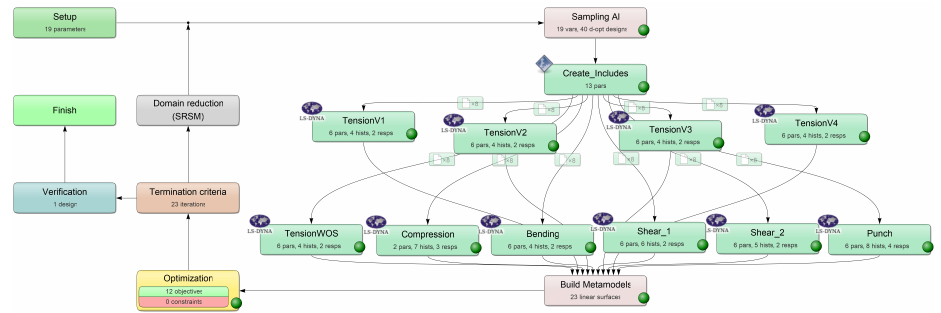
Figure 8. LS-OPT flowchart of material card calibration for the virtual experiment dataset (1 Step